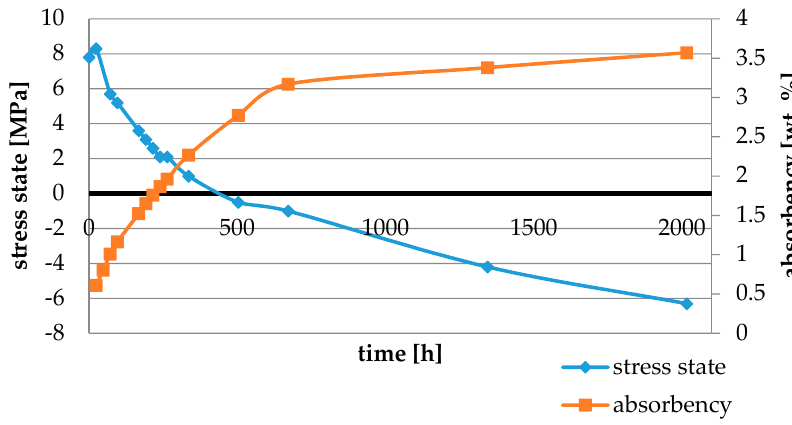
Figure 7. The influence of water sorption (2016 h water ageing) on the absorbency and contraction stress generated during the photopolymerization of Panavia 2.0.